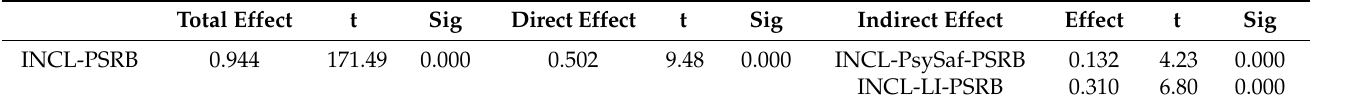
Table 5. Mediating